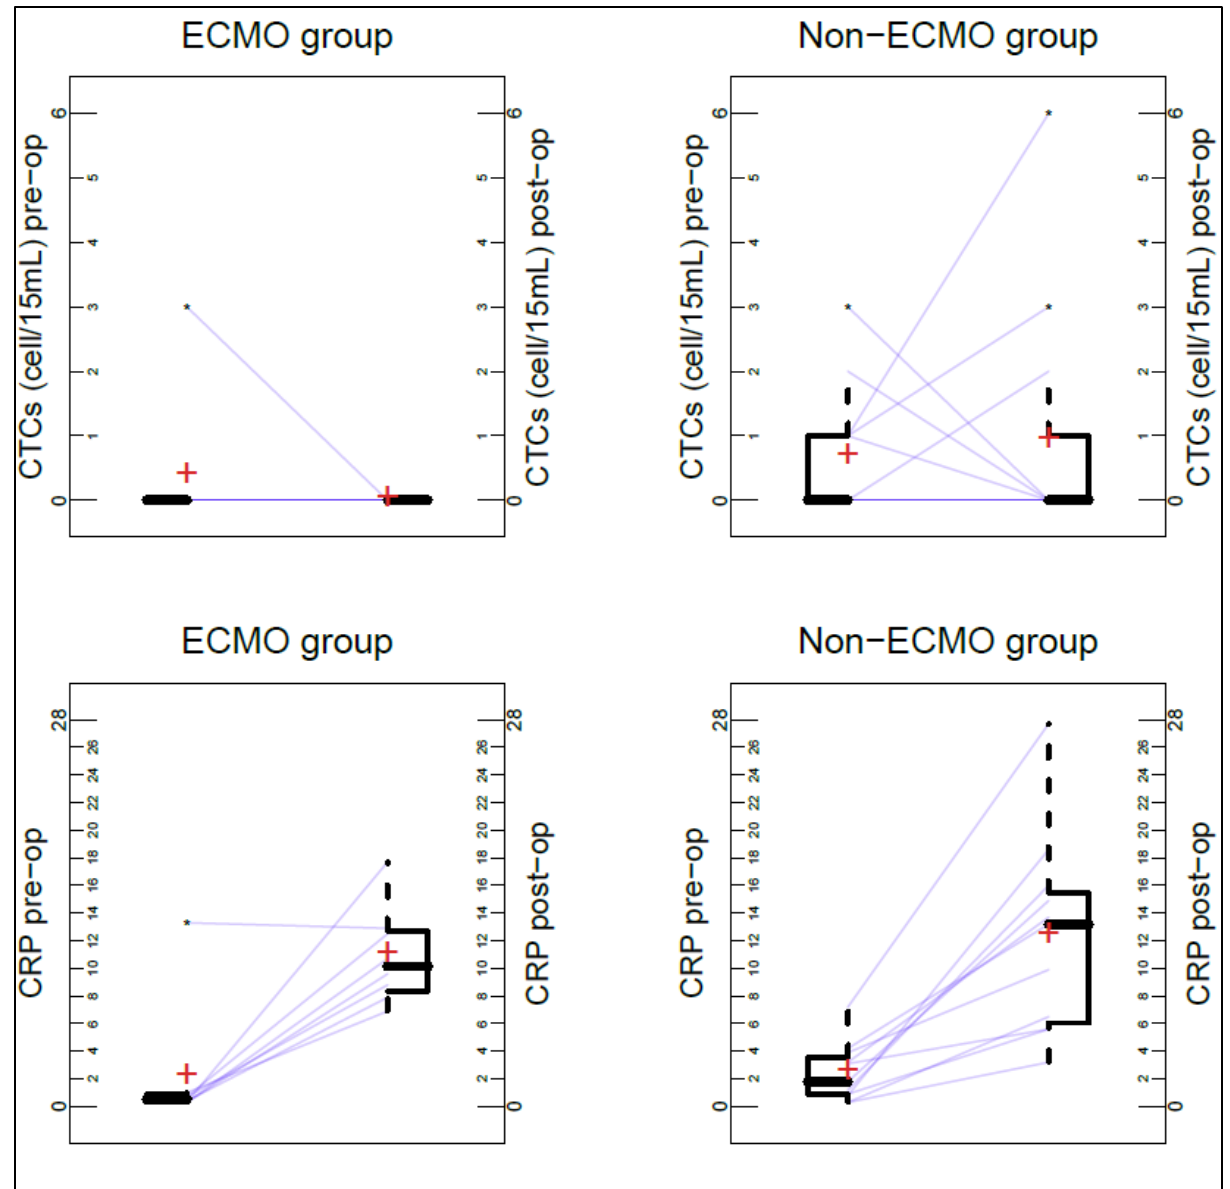
Figure 2. Distribution and individual trajectories of CTCs and CRP pre- and post-op, among patients with and without intraoperative ECMO. Matched box plots showing quantitative changes (pre-op and post-op) of CTCs and CRP in each patient. Half boxes represent the interquartile range and the horizontal bold lines across the boxes indicates the median. Arithmetic means are indicated with the + symbol. The asterisks indicate the values of any data points which lie beyond the extremes of the whiskers (the whiskers extend to the most extreme data point which is no more than 1.5 times the IQR away from the box).